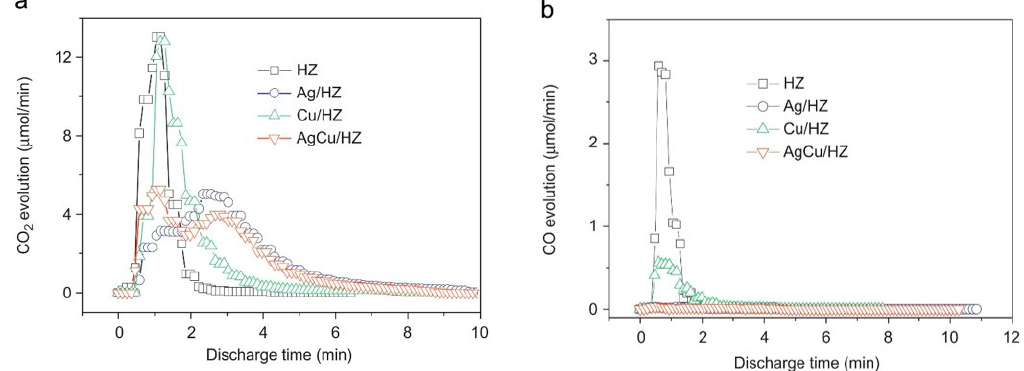
Figure 14. ( a ) CO 2 and ( b ) CO evolutions with discharge time in plasma catalytic oxidation of stored HCHO over HZ, Ag/HZ, Cu/HZ, and AgCu/HZ catalysts (storage stage: simulated air at 300 mL/min, 50% relative humidity (RH), GHSV = 12,000 h − 1 , C HCHO = 24.4 ppm (HZ), 27.2 ppm (Ag/HZ), 26.7 ppm (Cu/HZ) and 26.6 ppm (AgCu/HZ), t = 40 min; discharge stage: O 2 at 60 mL/min, P APC Reprinted from Reference [44], with permission from